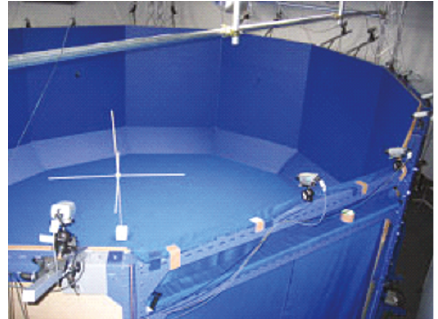
Figure 1: Studio for TVM generation.